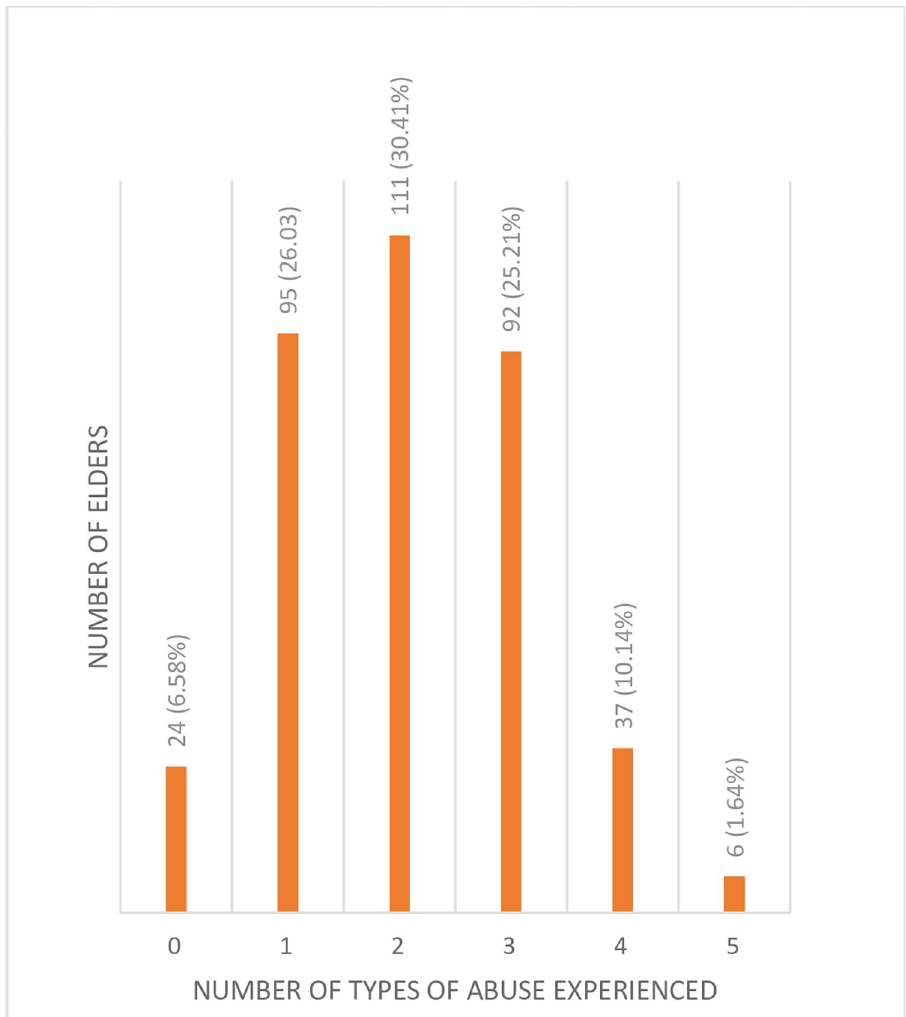
Fig 1. Histogram of number of abuses experienced by the elders.